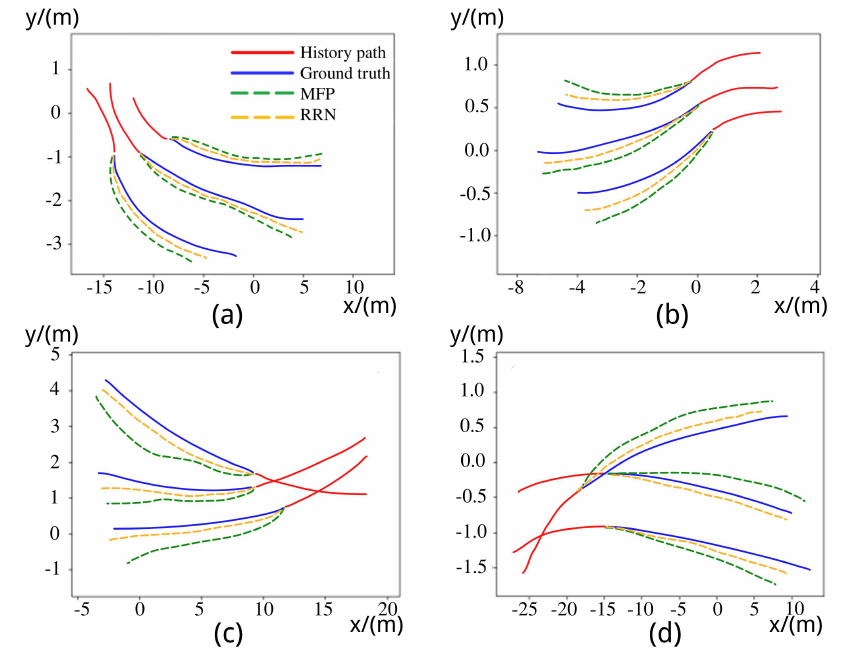
Figure 6. Examples of trajectory visualization on the INTERACTION. We present the prediction results (in meter) of MFP and RRN in the roundabout conditions. Subfigures ( a – d ) illustrate predicted trajectories of 4 various cases on the INTERACTION